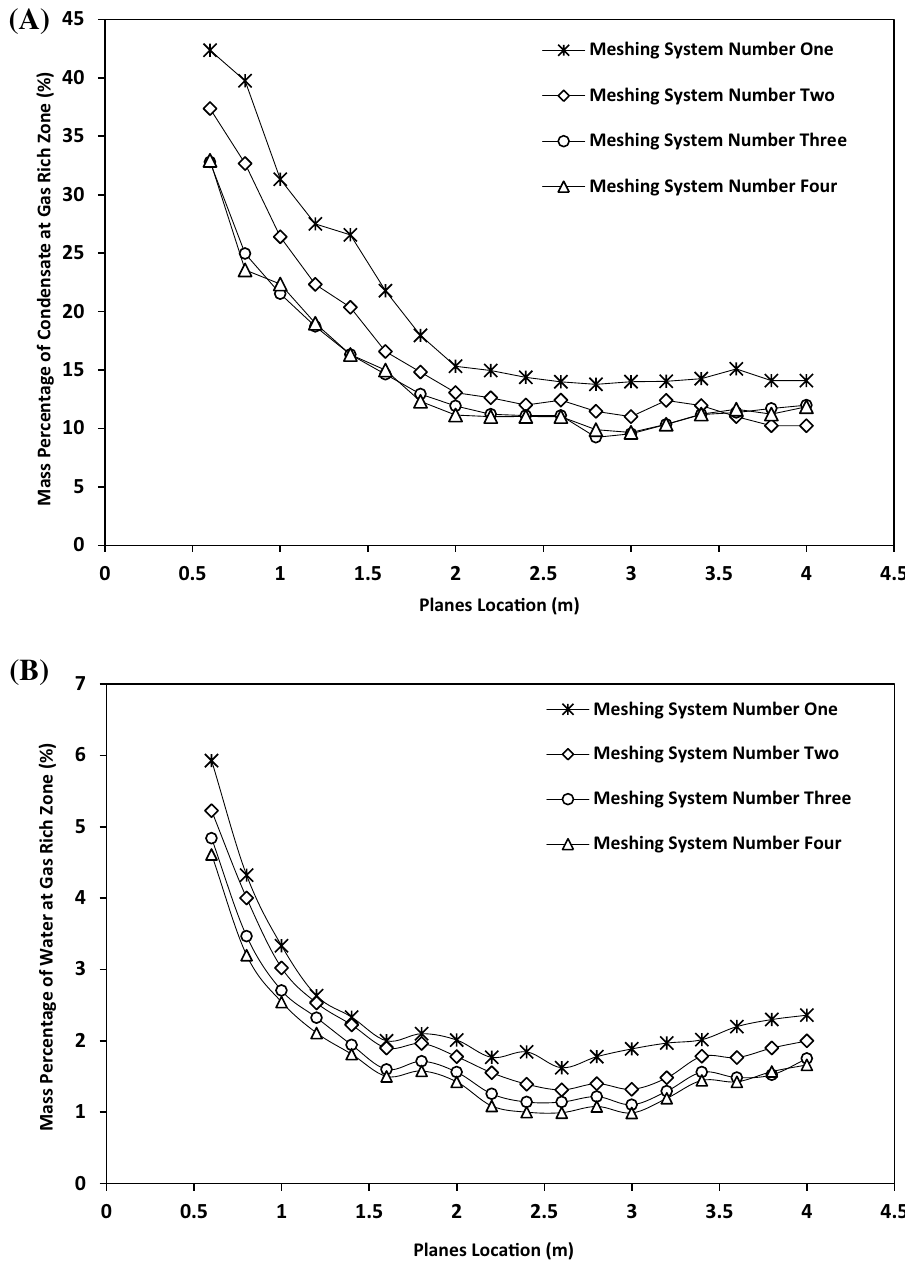
Fig. 3 Simulation results of the mesh independence test in terms of the mass distribution of condensate ( a ) and water ( b ) droplets in the gas-rich zone